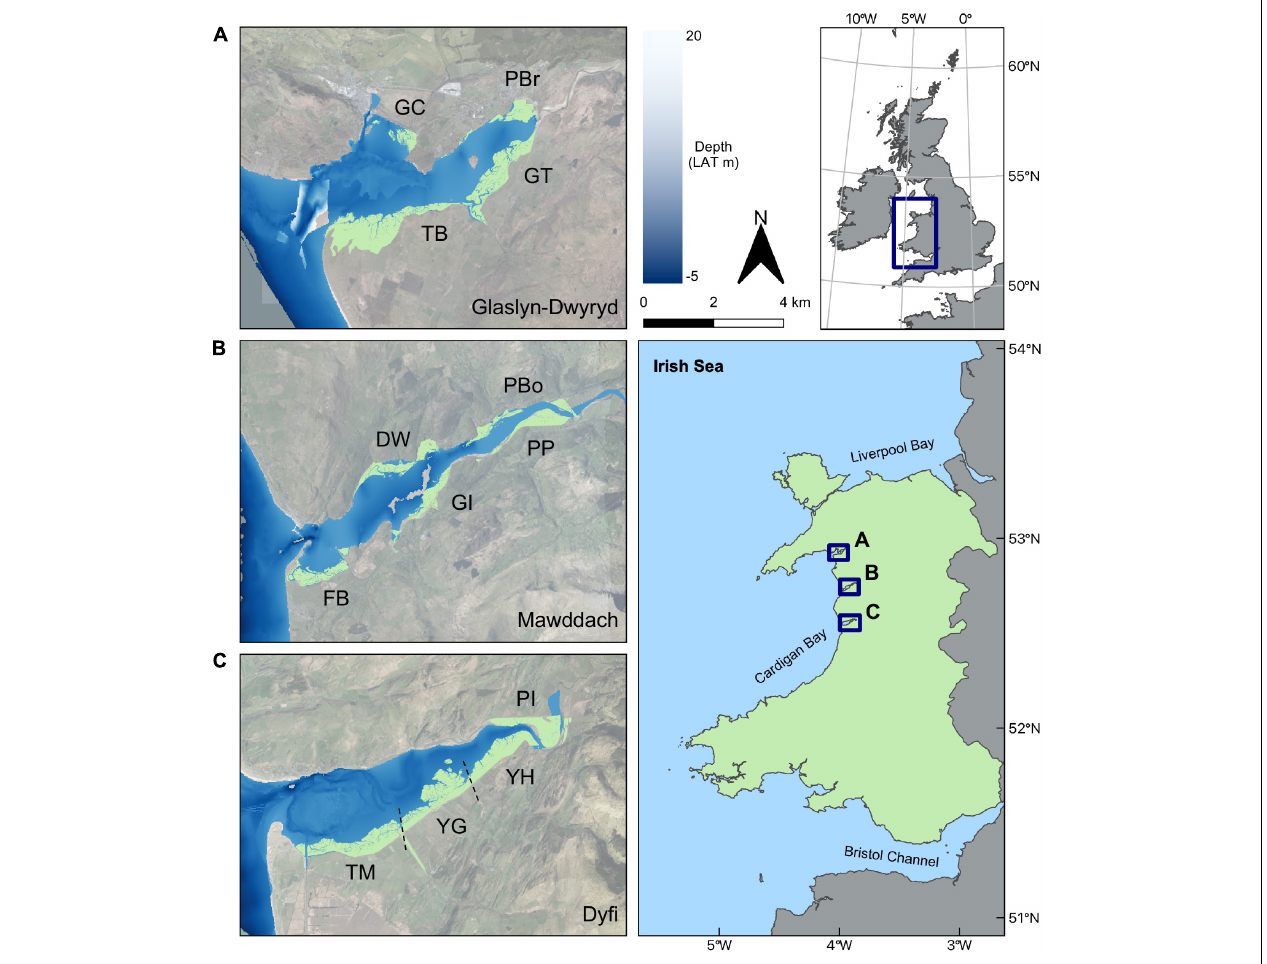
FIGURE 2 | Locations of the three estuary complexes in Cardigan Bay, West Wales, United Kingdom: (A) Glaslyn-Dwyryd, (B) Mawddach, and (C) Dyfi. Marsh sites in (A–C) are shown in light green color. Labels refer to the names of salt marsh sites (GC, Glaslyn Cob; TB, Traeth Bach; GT, Glastraeth; PBr, Pont Briwet; FB, Fairbourne; DW, Dwynant; GI, Garth Isaf; PP, Penmaenpool; PBo, Pont Borthwnog; TM, Traeth Maelgwyn; YG, Ynys Greigiog; YH, Ynys Hir, and; PI, Penmaen Isa). The estuarine depth scale is in meters relative to the Lowest Astronomical Tide